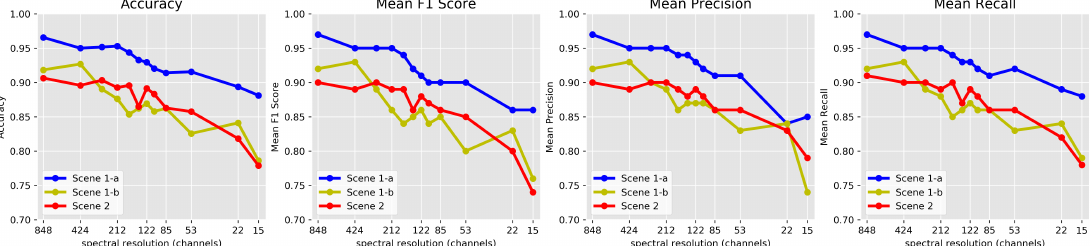
Figure 10. Accuracy and the weighted average of the F 1 measure, precision, and recall ( left to right respectively) of CNN Model 2 trained on labeled data for each scene with varying spectral resolutions. The performance shows a decreasing trend with decreasing spectral resolution in all three scenes, with the model trained and tested on Scene 1-a outperforming Scenes 1-b and 2 at all spectral